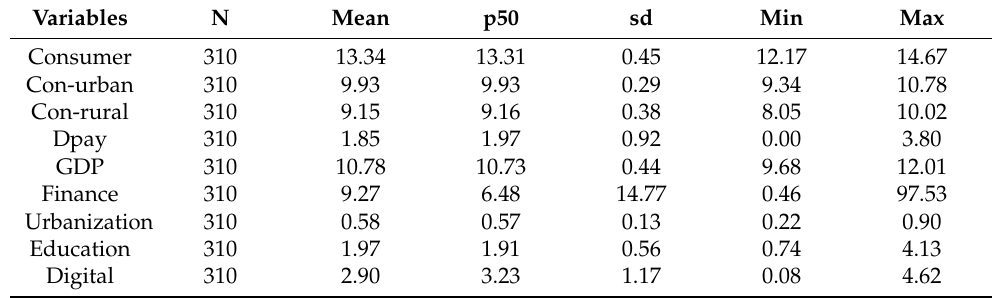
Table 2. Descriptive analysis.